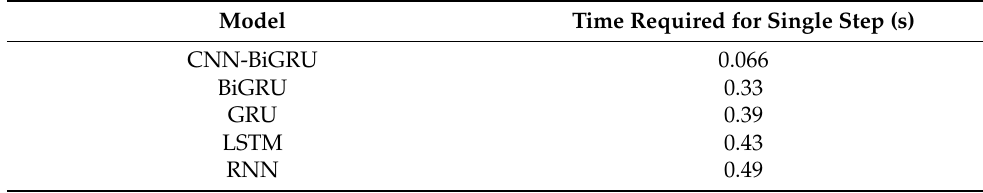
Figure 6. Training loss curves of different models. Table 5. Comparison of time required for single step of each model.